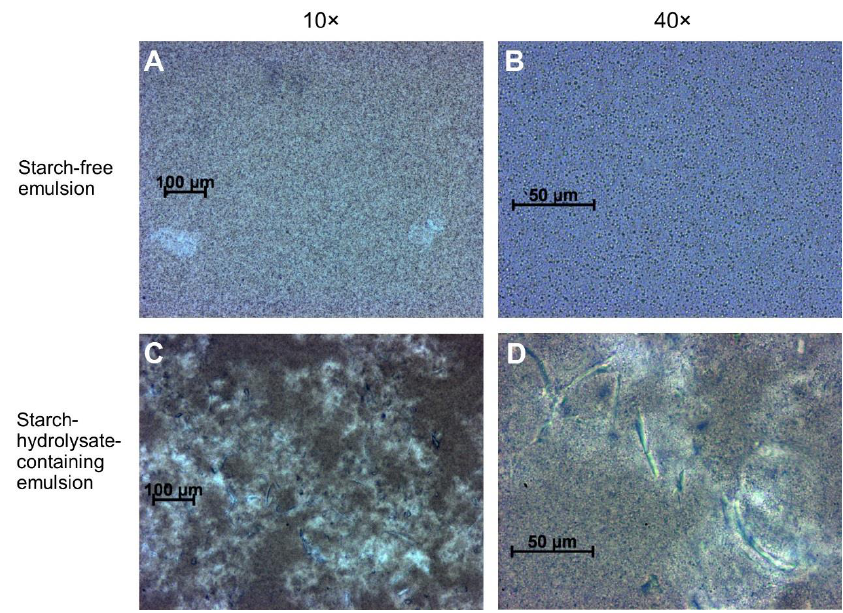
Figure 5. Microstructure of faba bean starch-free emulsions ( A , B ) and starch-hydrolysate-containing emulsions ( C , D ) observed in an optical microscope with 10× ( A , C ) and 40× ( B , D ) objectives.